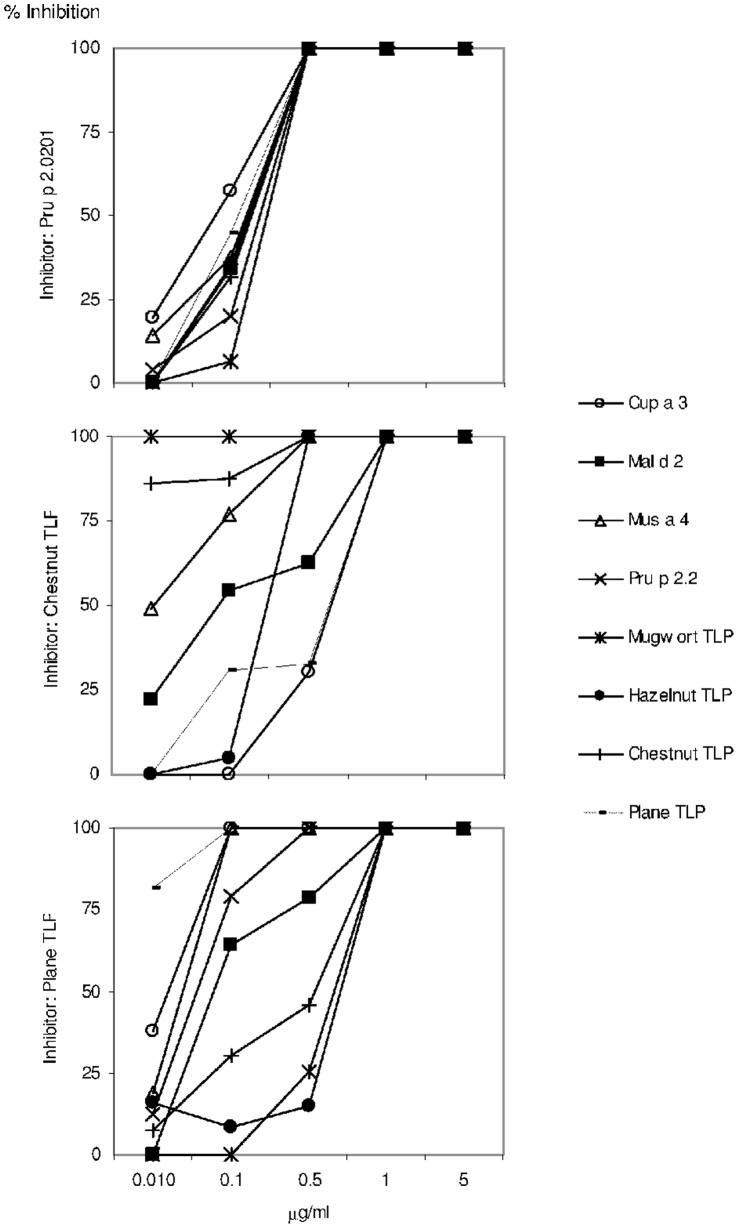
IgE binding inhibition of the TLP microarray, when serum pool (n = 21; three per area) or individual sera were preincubated for 3 h at room temperature with increasing amounts of Pru p 2.0201, and chestnut and plane -pollen TLPs.